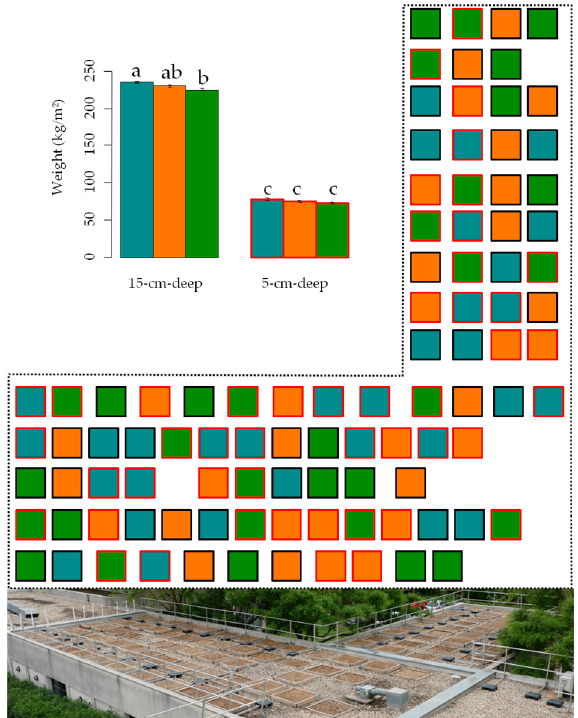
Figure 2. Experimental design and weight of the 96 quadrats installed on the roof of Avignon Technology Institute (IUT) (Southeastern France). Mixtures are indicated by the color background (blue: 25% pebble-sand and 75% clay-silt; orange: 50% pebble-sand and 50% clay-silt; green: 75% pebble-sand and 25% clay-silt) and the substrate thicknesses by the color of the quadrats framing (red: 5 cm, black: 15 cm). The given values are means ± standard errors. Two values in the same row with a different letter are significantly different according to Mann-Whitney-Wilcoxon test (with Bonferroni adjustment [52]).